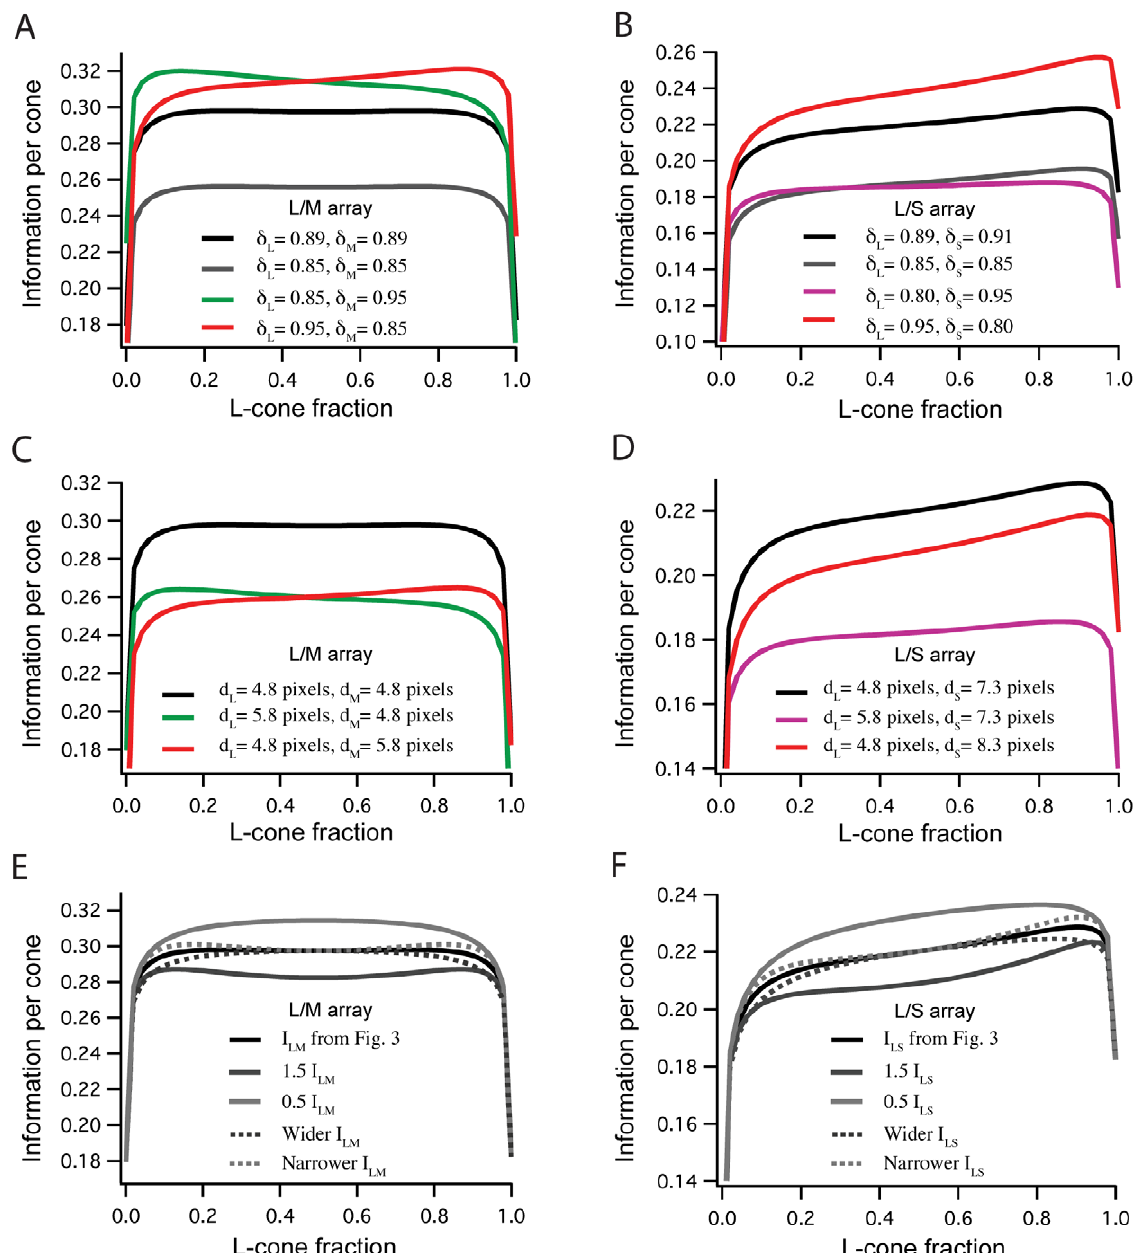
Figure 6. Variations in the optimal mosaic. Information per cone as a function of L cone fraction is shown for various scaling exponents, chromatic PSFs, andforms of themutualinformationbetween cone classes. (a) Varying thescaling exponents d L and d M jointly hadlittle affecton theflatness of the LM information curve. Differential scaling in L vs. M of about 10% led to approximately 3% higher information transmission rate for L or M dominant arrays (depending on which channel scaled with higher exponent). (b) Varying the scaling exponents, d L and d S had little affect on the optimal ratio of L andS cones, unless the L channel scaled with a substantially smallerexponent thantheS channel. (c) Increasingblur in theL or M channel (while keeping the other channel’s blur fixed) led to an M or L dominated optimal mosaic, respectively. A 25%increase in blur was necessary to incur a 5% advantage for a mosaic dominated (90%) by one cone class. (d) A 25% increase in the blur in the L channel relative to the S channel was necessary to significantly reduce the advantage of an L cone dominated mosaic relative to an S cone dominated mosaic. (e) Adjusting the peak or width of the form of the LM mutual information curve (see Fig. 3 ) had small effects on the flatness of the LM information curve. A more peaked or narrower mutual information (see text) curve led to a 2% advantage for either an L or M dominant mosaic. A less peaked or wider mutual information curve led to a 1% advantage for an evenly mixed LM mosaic. (f) The same adjustments to the LS mutual information curve had little effect on the optimal L/S ratio.